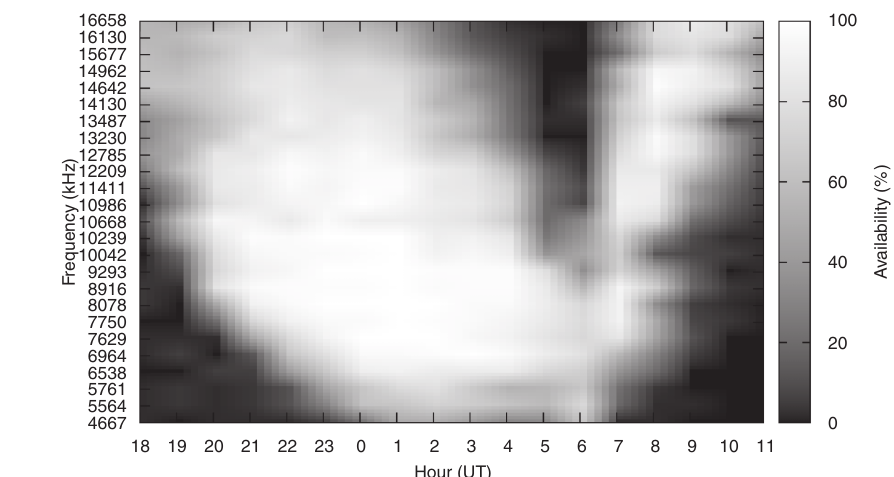
Fig. 6. Averaged link availability as a function of the hour and the frequency (adapted from Vilella et al. ,